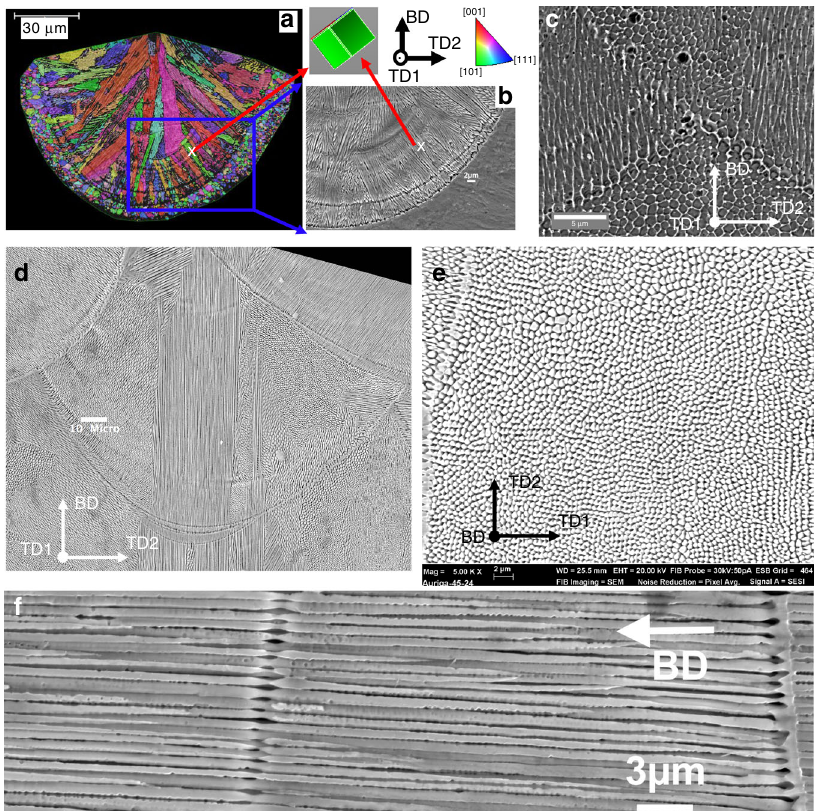
Fig. 1 Solidi fi cation microstructure in a single-track and in a multi-layer build of HEA. a EBSD inverse pole fi gure (IPF) map along build direction (BD) and b secondary electron image of cells in a single track of HEA. c Cells in regions far away from the build/substrate interface. d – f Solidi fi cation microstructure in 316L fabricated by a Renishaw: d Cells in a melt pool of 316L, e and f Transverse and longitudinal sections of a cell domain within a melt pool, respectively. Note: Figure a and b were re-used from ref. 13 under the terms of the Creative Commons Attribution License (CC